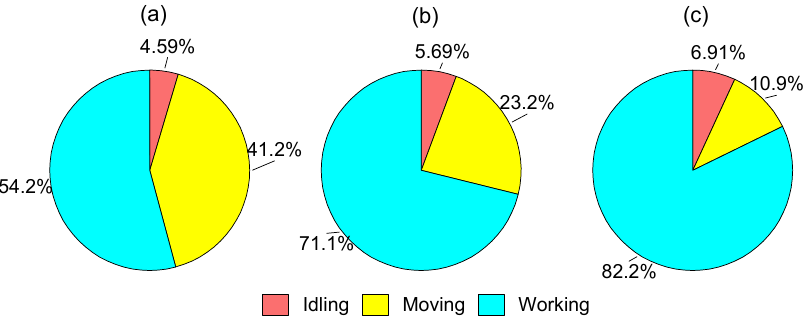
Figure 2. Real ‐ world operation modal share for test machines: ( a ) WL; ( b ) FL; ( c ) EX. Figure 2. Real-world operation modal share for test machines: ( a ) WL; ( b ) FL; ( c )